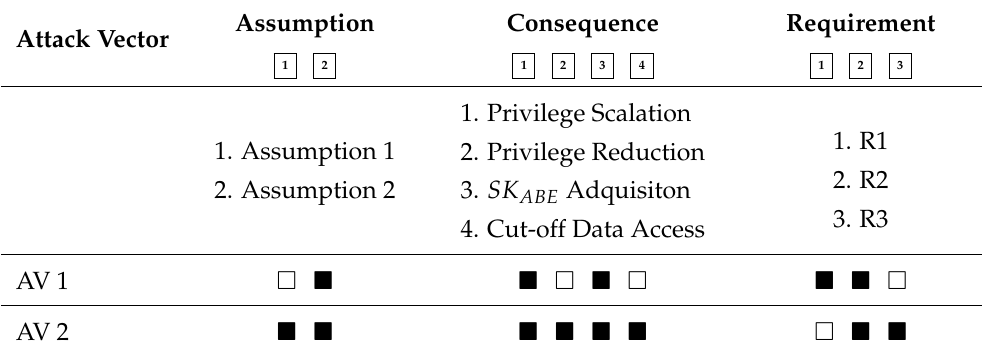
Table 1. Attack vector, assumption, and solution